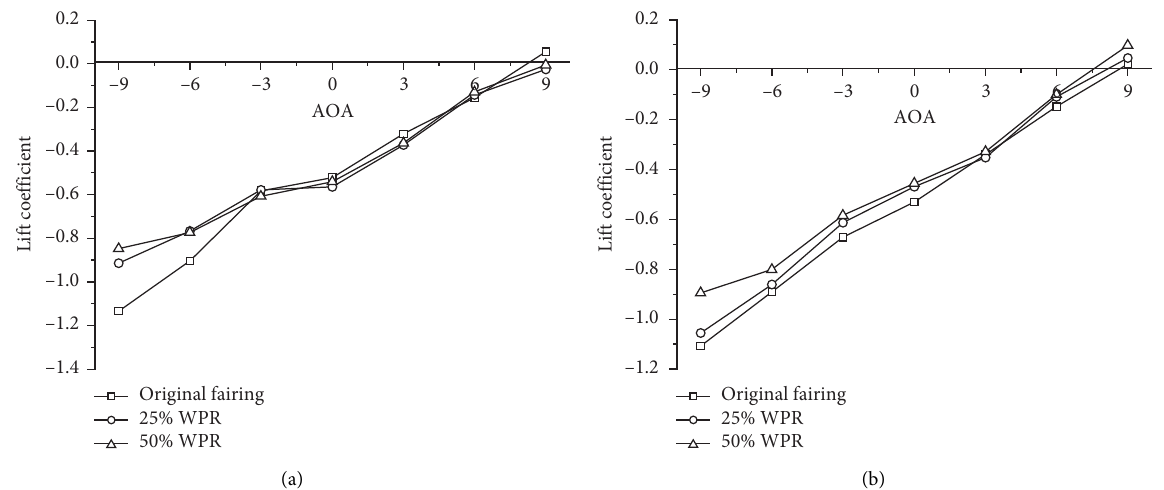
Figure 9: Static wind tunnel test results for C